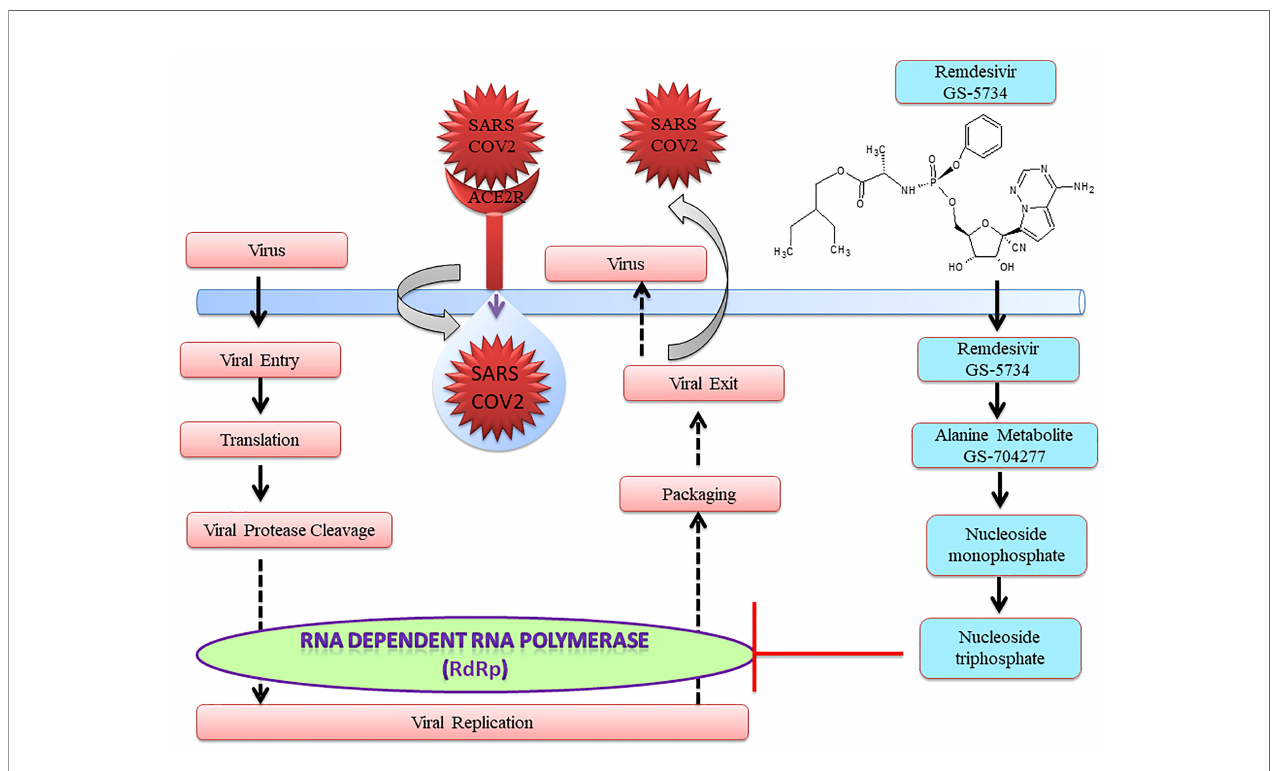
FIGURE 1 | Schematic representation of remdesivir as a repurposed drug for COVID-19.